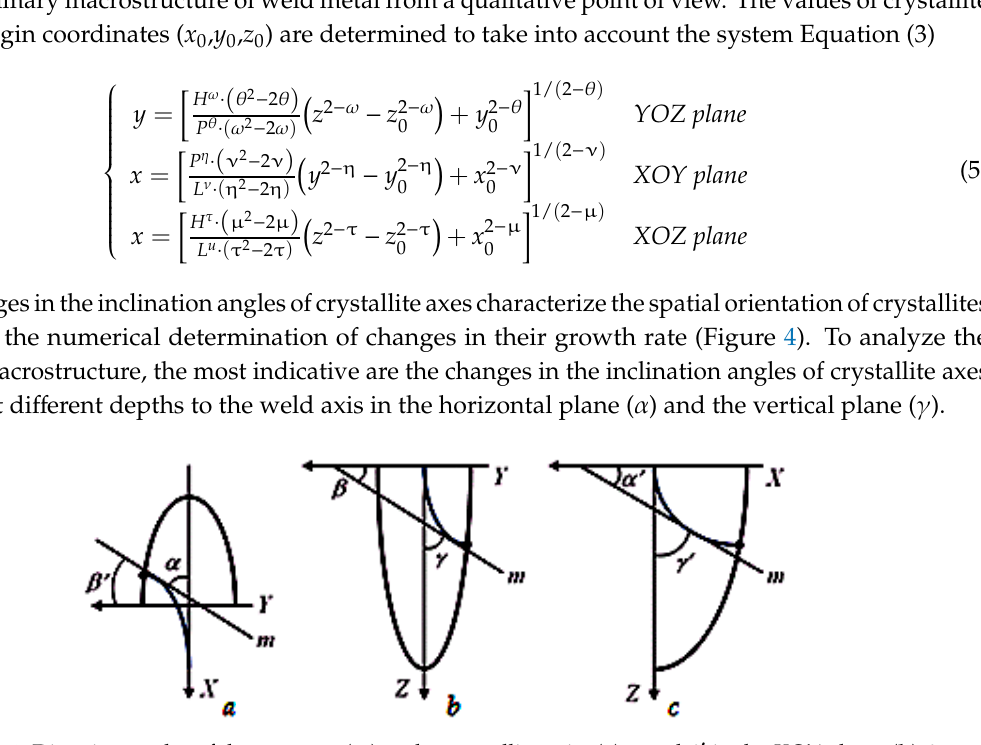
Figure 4. Direction angles of the tangents (m) to the crystallite axis: ( a ) α and β ’ in the XOY plane, ( b ) β and γ in the YOZ plane, ( c ) α ’ and γ ’ in the XOZ plane.